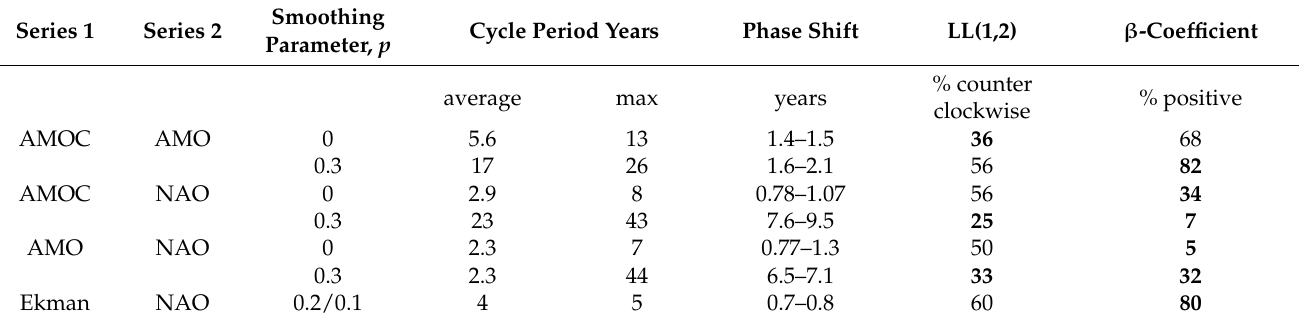
Table 1. Characteristics of Lead–lag relations between pairs of North Atlantic climate modes. The bold numbers in the two last columns suggest that for the corresponding pairs, identifying LL relations with cross-correlation techniques may give results that are similar to